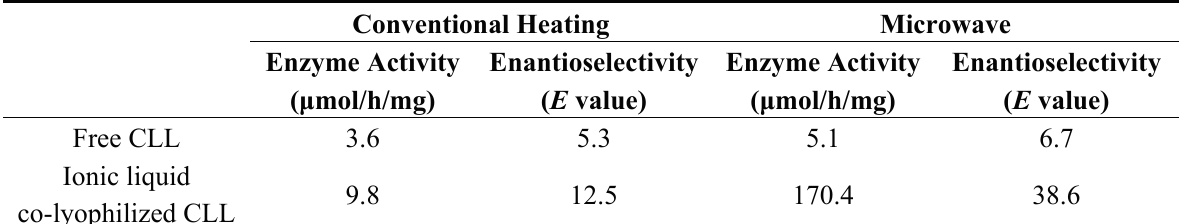
Figure 1. Effects of [Bmim] BF 4 content during lyophilized preparation on the enzyme activity ( μ mol/h/mg, ○ ) and the enantioselectivity ( E value, ● ) in enantioselective esterification of α -lipoic acid. Reaction conditions: ( R , S )- α -lipoic acid (2 mmol), CLL (10 mg) co-lyophilized with different contents of [Bmim] BF 4 (wt %, IL/enzyme), n -octanol (5 mmol) and cyclohexane (10 mL) were performed at 30 °C and 150 rpm. Table 4. Effect of microwaves on the enantioselective esterification of α -lipoic